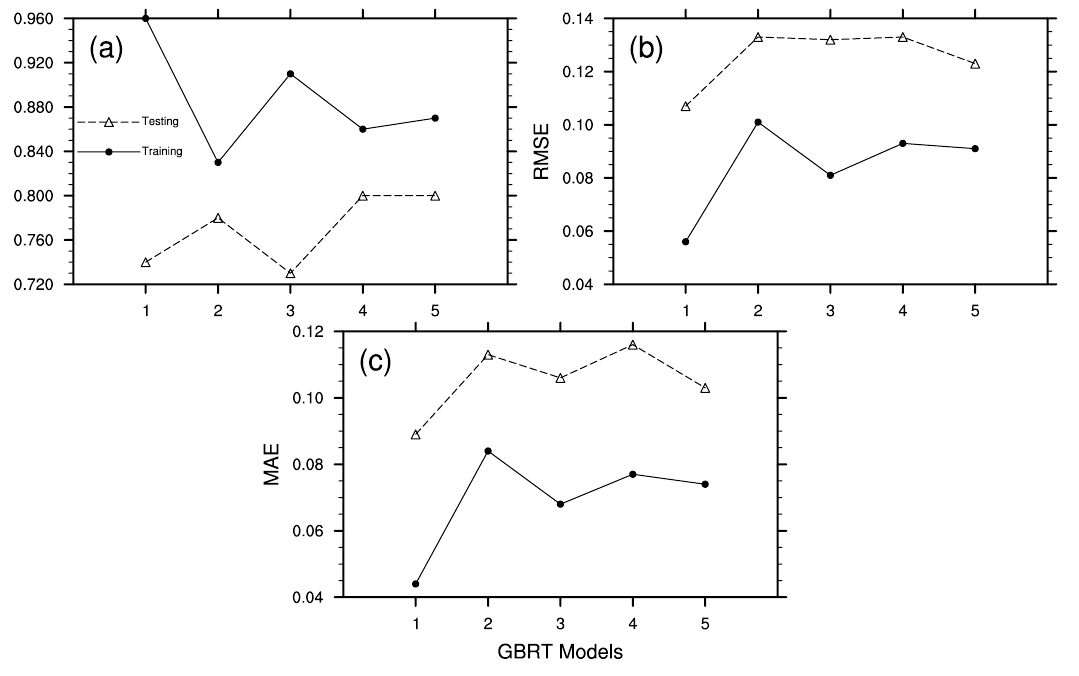
Figure 5. Correlation coefficient (r), root-mean-square deviation (RMSE) and mean average error (MAE) of GBRT-estimated CS compared with calibrated CS for both training and testing groups of five GBRT prediction models. ( a ): Correlation coefficient (r); ( b ): root-mean-square deviation (RMSE); ( c ) mean average error